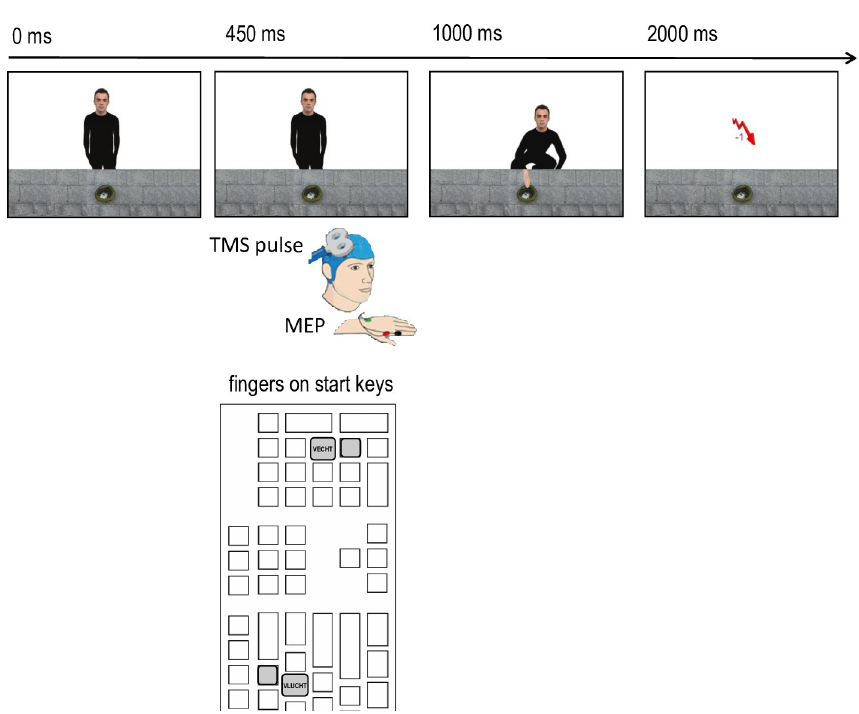
Fig 3. Order of events in an observation trial of the test phase in the easy-flee condition with the right-fight-left- flee hand-R mapping. After a TMS pulse at 450 ms, the avatar crouched and stole the money at 2000 ms post-stimulus